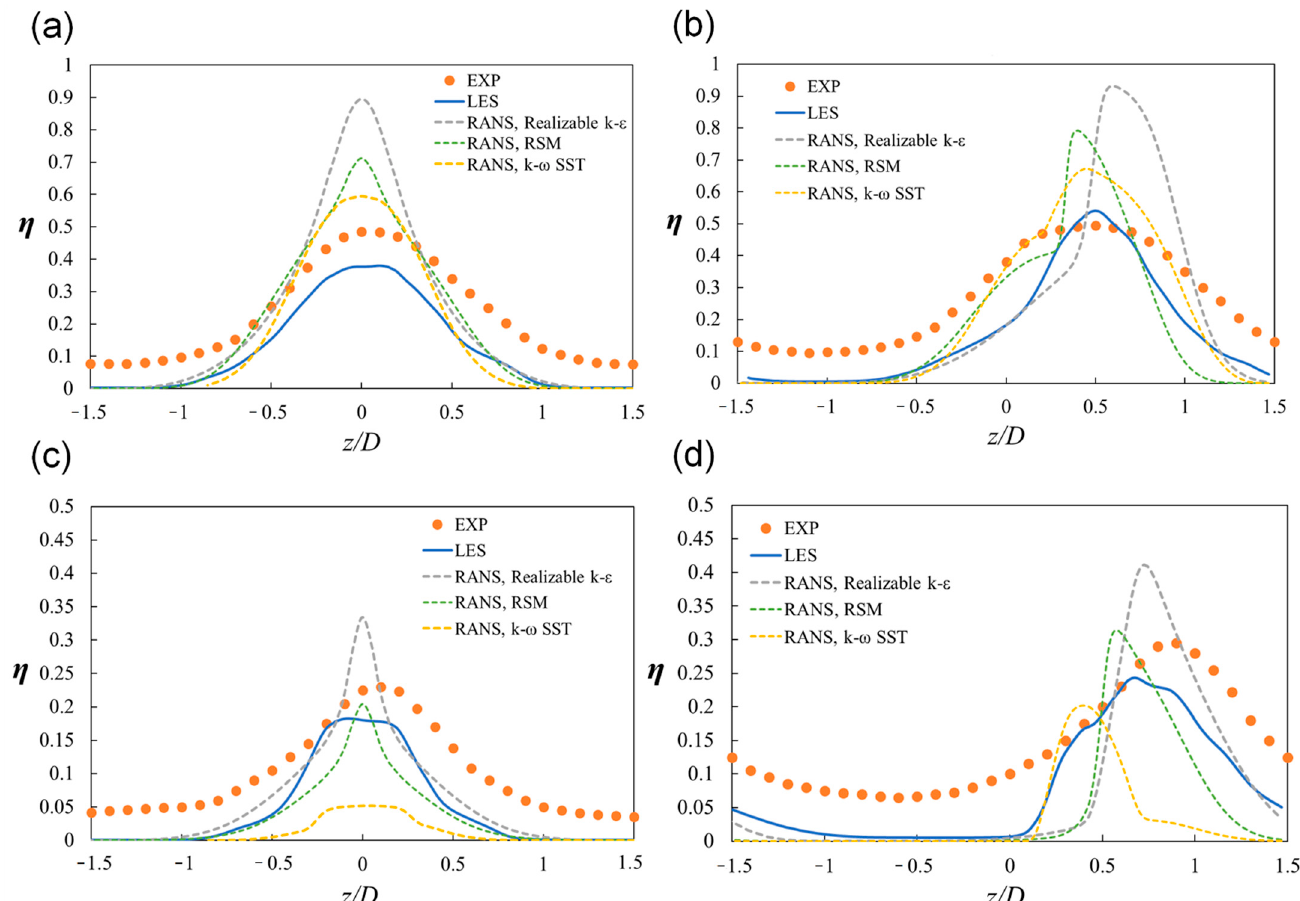
Figure 9. Spanwise variations in the adiabatic film cooling effectiveness at x/D = 2.5: ( a ) M = 0.5, β = 0°; ( b ) M = 0.5, β = 30°; ( c ) M = 1.0, β = 0°; and ( d ) M = 1.0, β = 30°.